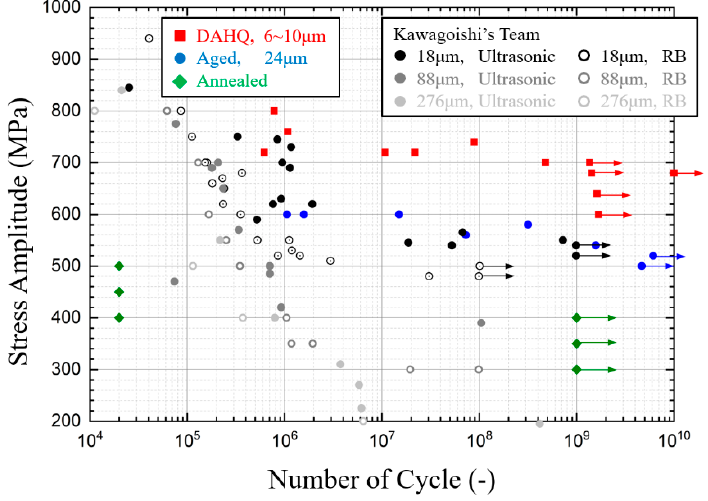
Figure 8. Comparison of VHCF properties with Kawagoishi’s team [16–18,37,38].